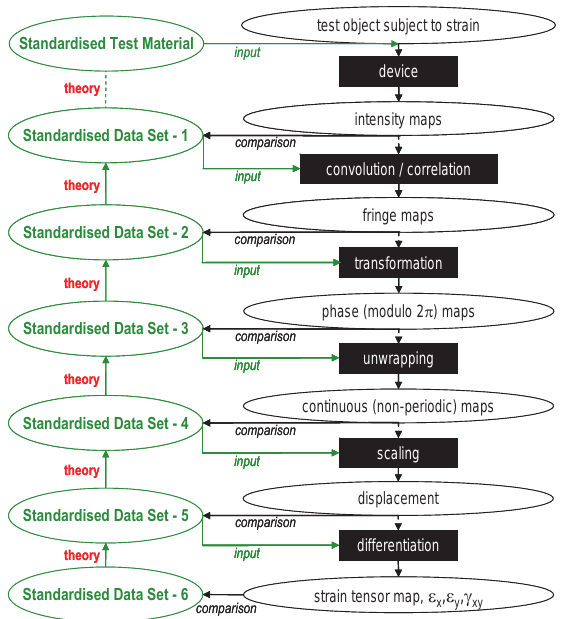
Fig. 5 Schematic illustrating the generic measurement process ( right ) for optical strain measurement systems and the relationship of the SPOTS standardized test and data sets ( left ) to the process. The ovals represent data sets and the rectangles represent components of the strain measurement system. (© SPOTS